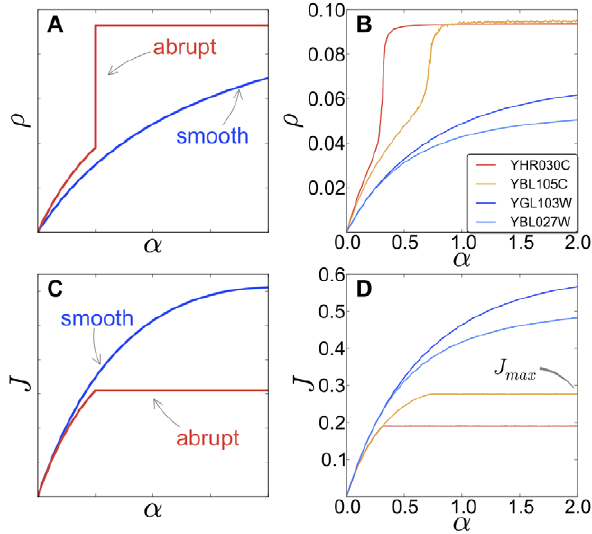
Figure 4. Outcomes for some mRNAs obtained by stochastic simulations of the model. Panels ( A ) and ( C ) show a sketch of the two different behaviours one can obtain for the density of ribosomes r and the current J , respectively. The genes are divided in two categories, according to the shape of r ( a ) , as shown in ( A ): abrupt mRNAs (red, colour online) present a steep increase of the polysome size with increasing the initiation rate. On the other and, smooth sequences (blue, colour online) do not show this feature. The current ( C ) is also affected, with abrupt genes exhibiting a sudden change, or ‘kink’ in the current, while the current of smooth mRNAs does not suddenly saturate. Panels ( B ) and ( D ) show the outcome of numerical simulations of real sequences from S. cerevisiae . Genes YGL103W and YBL027W are ribosomal proteins while YHR030C and YBL105C are kinase regulatory proteins. J max indicates the saturation value of the current (see